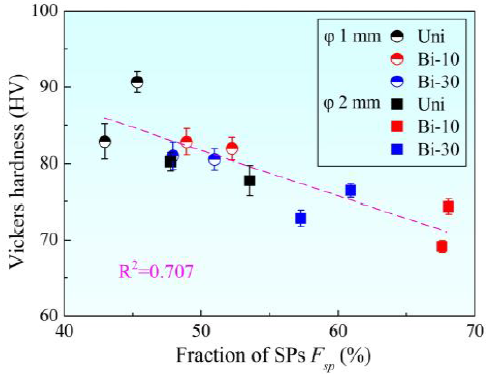
Figure 8. Relationship between Vickers hardness and F sp value.